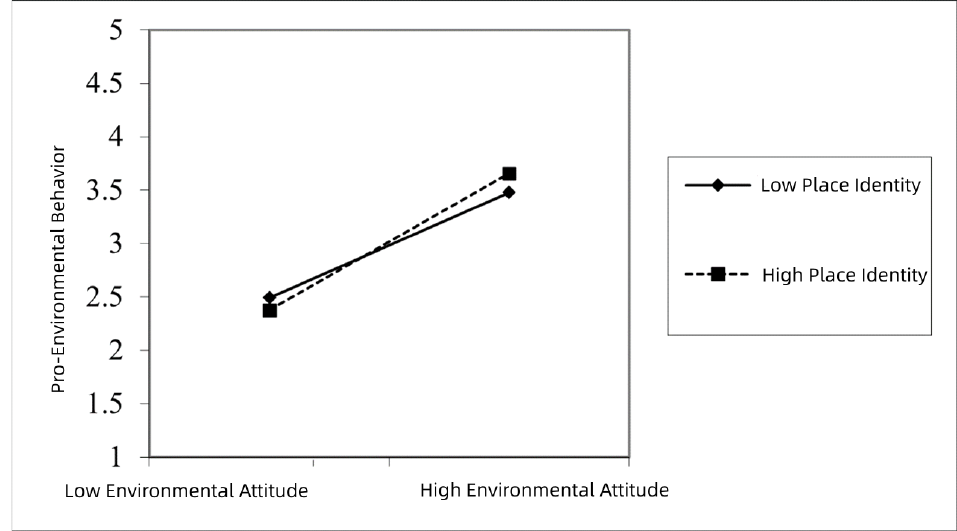
Figure 3. The moderating effect of place identity.